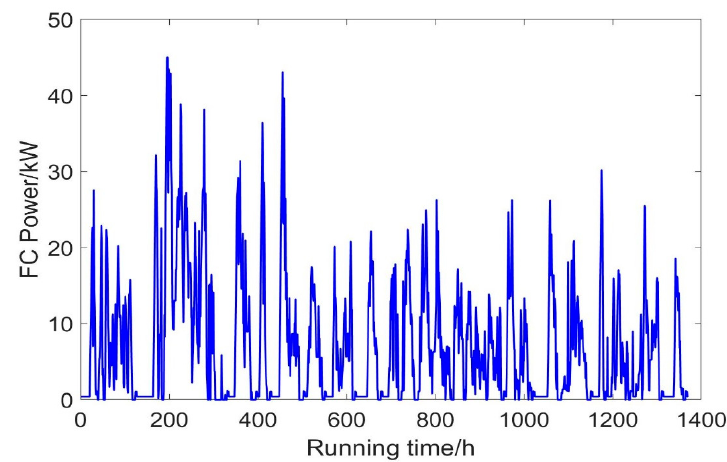
Figure 8. Fuel cell system power. Table 3. Fuel cell stack degradation rates (1 / h) and weight coe ffi cients.